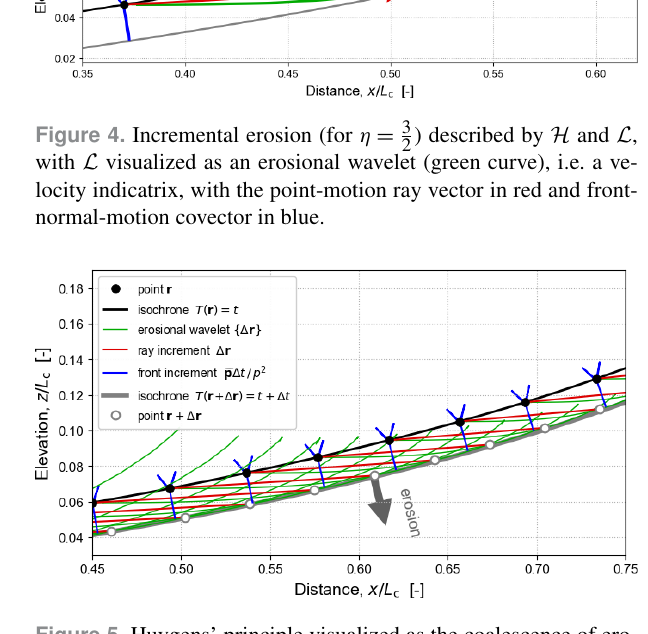
) at their mutual tangent 2